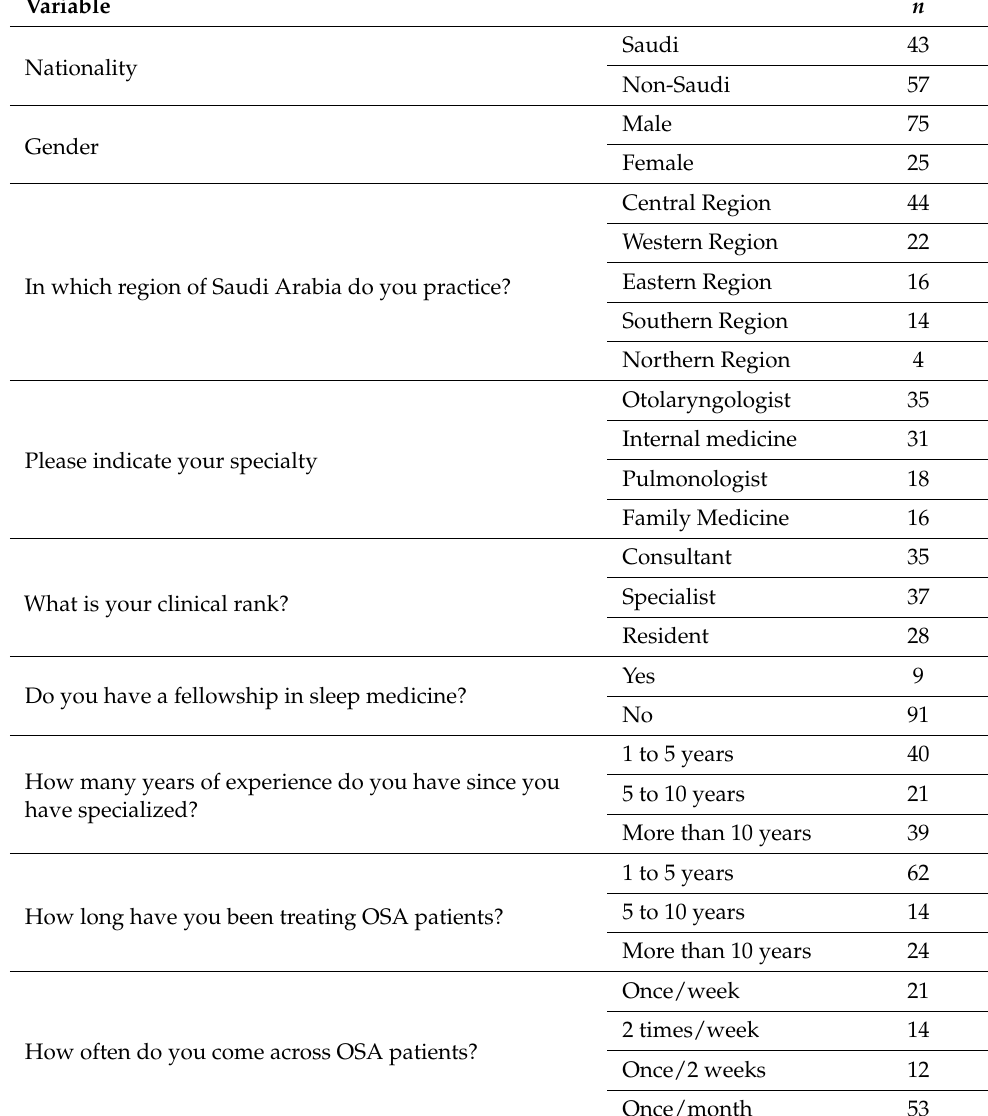
Table 1. Demographic and experience level of participants ( n =